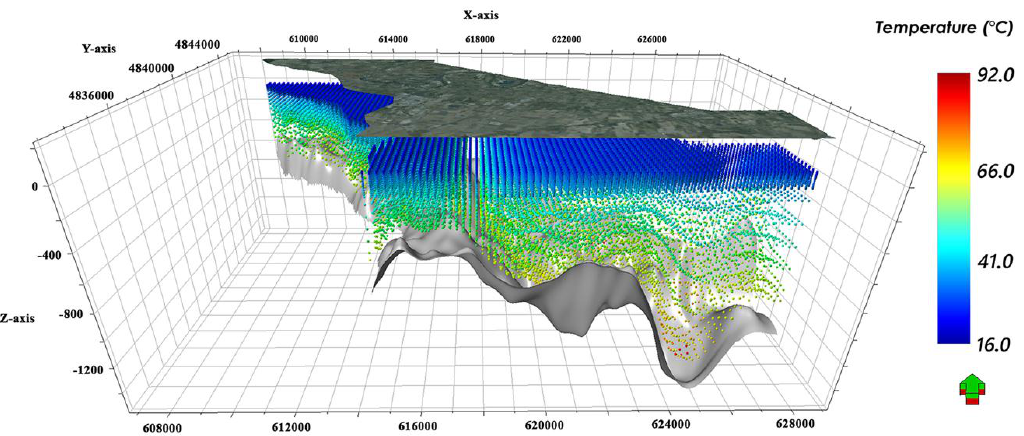
Figure 10. 3D point cloud of temperatures (from TOUGH2 simulation results) imported into the Petrel